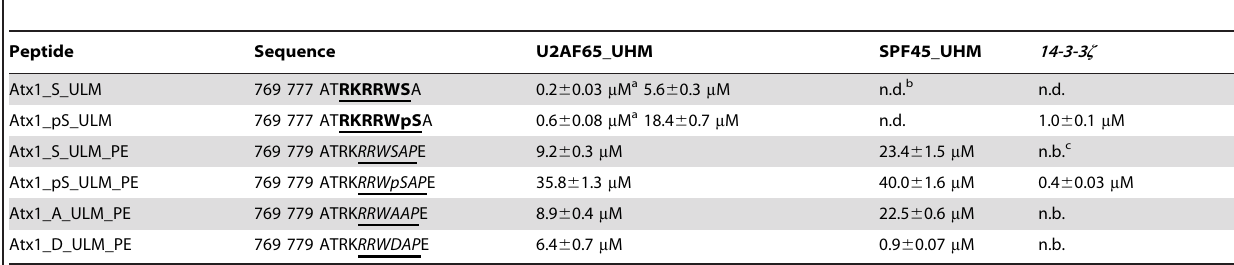
Table 1. Summary of the K d ’s as obtained from ITC measurements carried out with the different peptides.